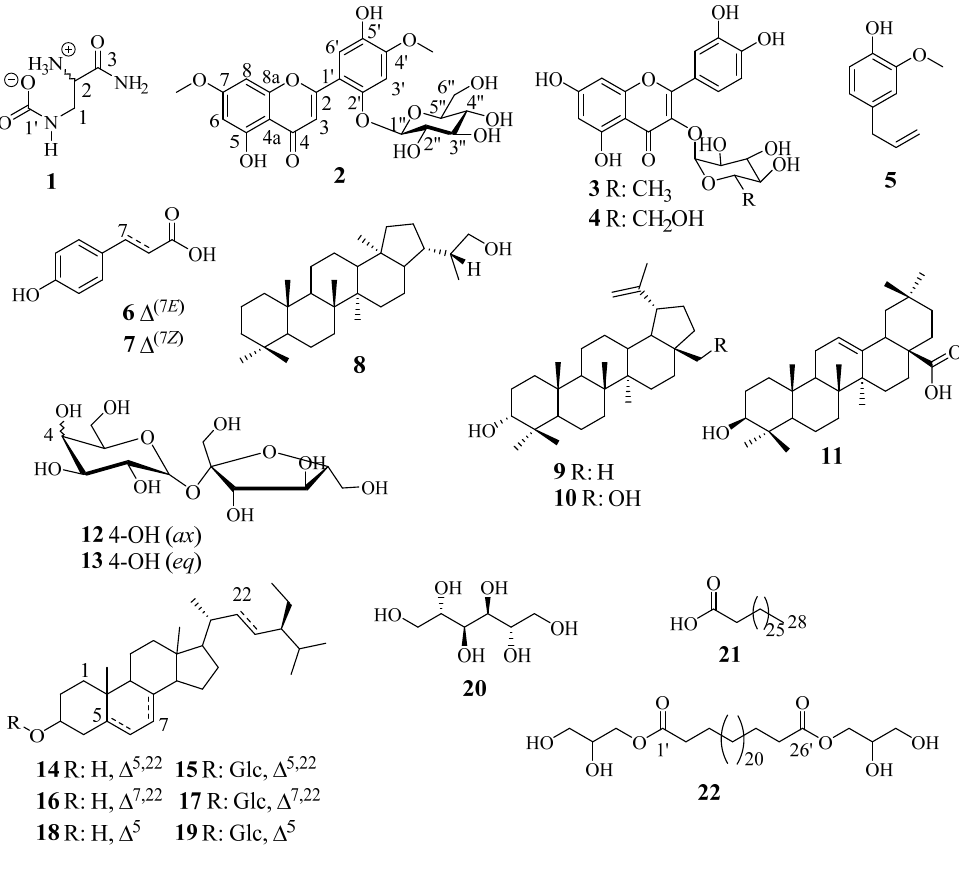
Figure 1. Structures of compounds 1 – 22